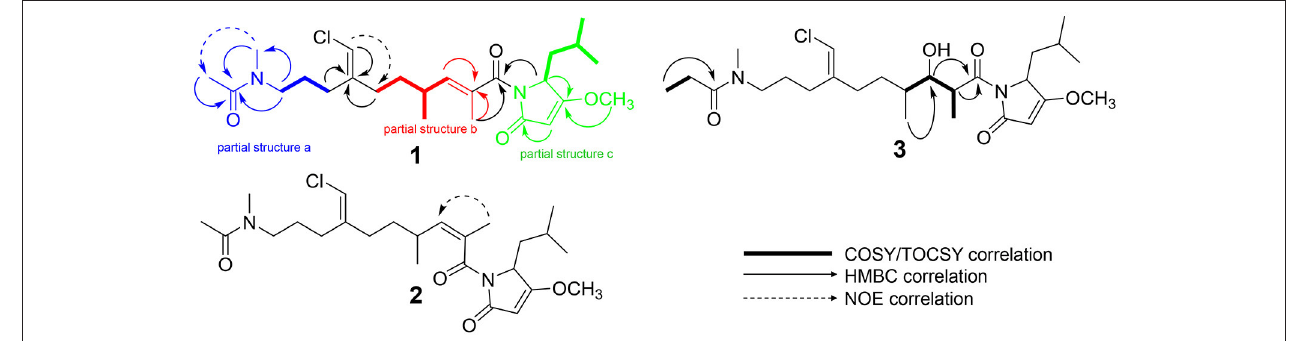
FIGURE 4 | Select 2D NMR correlations of compounds 1–3